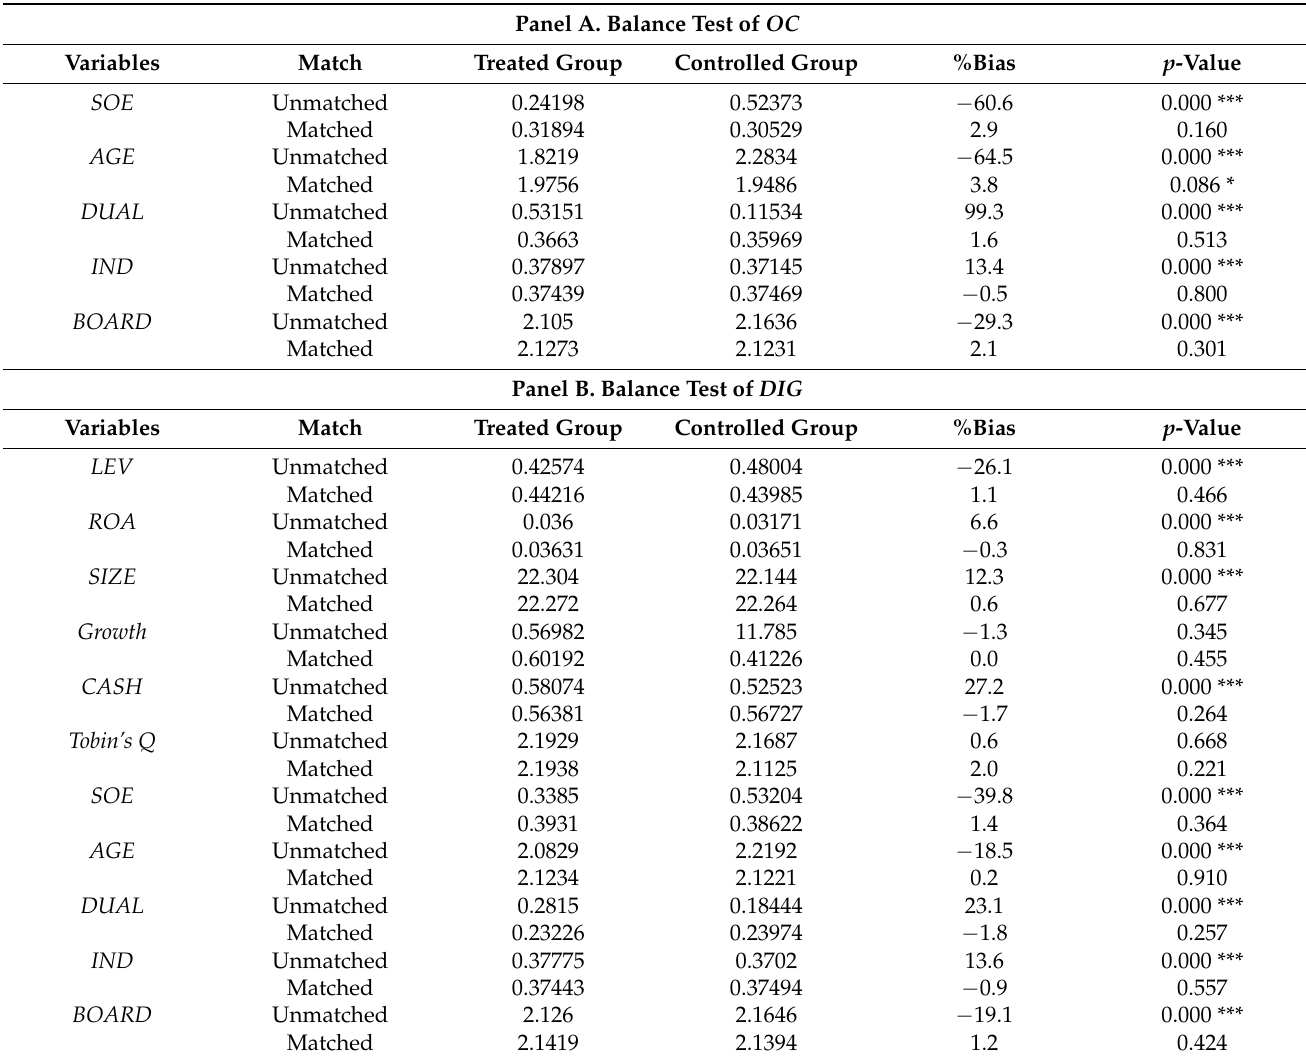
Table A3. Cont. Panel A. Balance Test of